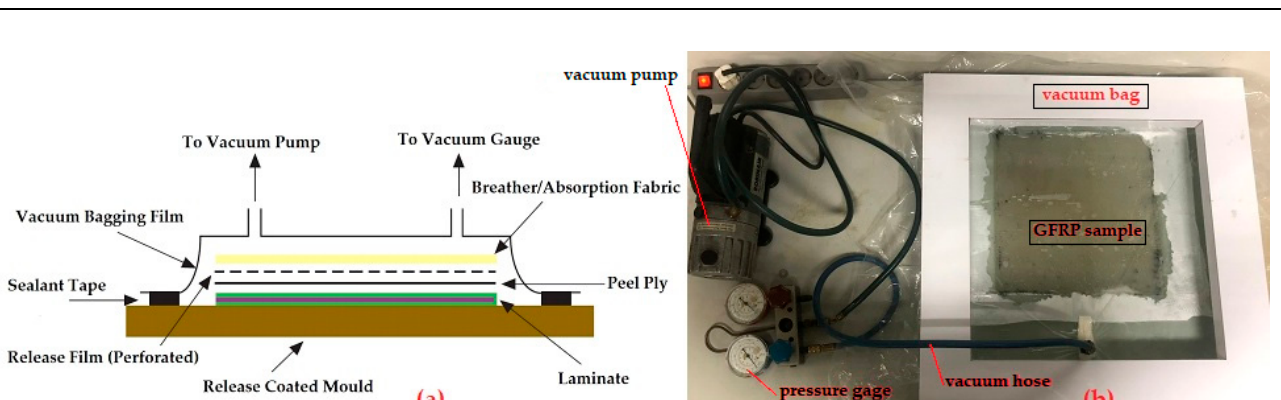
Figure 1. ( a ) The working principle of the vacuum technique; ( b ) A sample of GFRP being vacu ‐ umed.